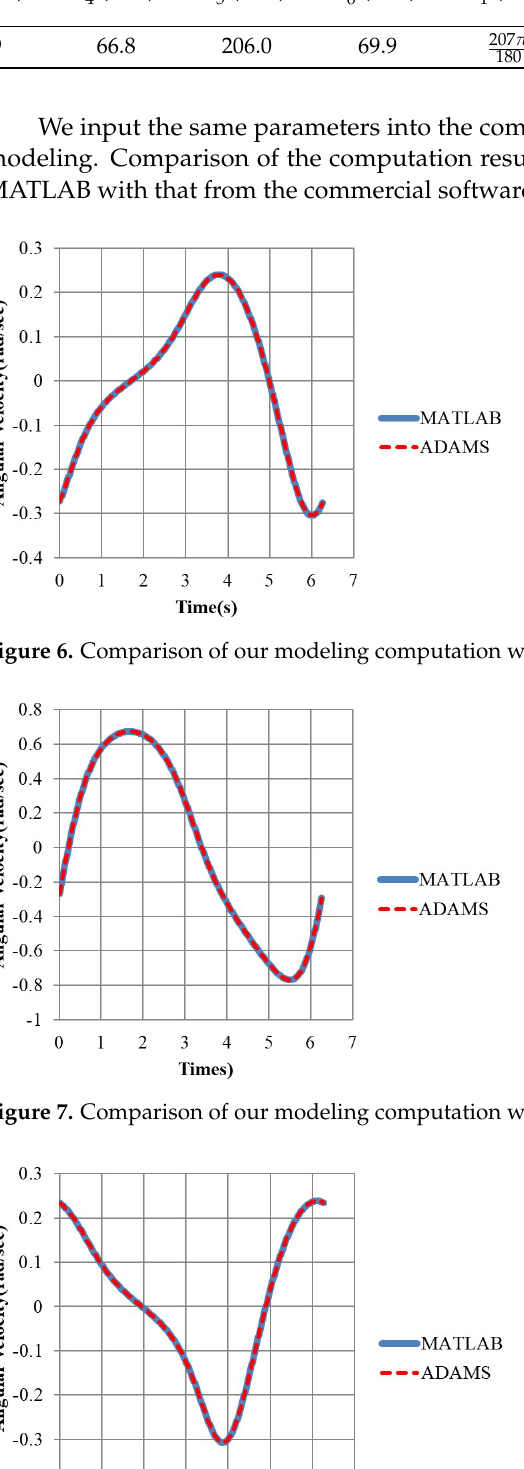
Table 1. Parameter values used in simulations.